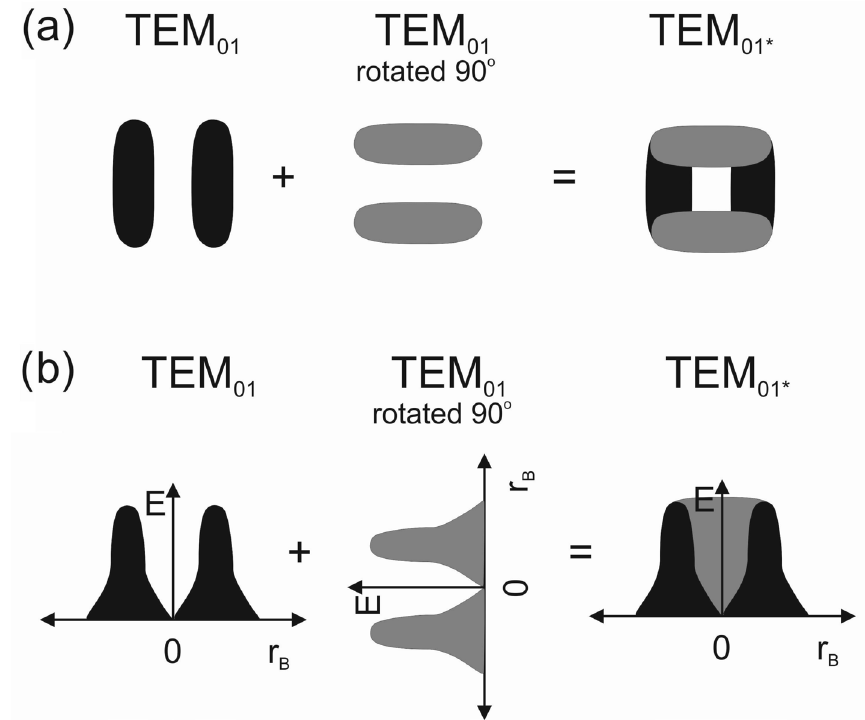
Figure 3. Schematic representation of TEM 01* mode: ( a ) the principle of the formation of TEM 01* mode as a superposition of two TEM 01 modes; ( b ) irradiance profiles in a cross -section of a laser beam with TEM 01 and TEM 01* modes. r B —laser beam radius; E —irradiance.